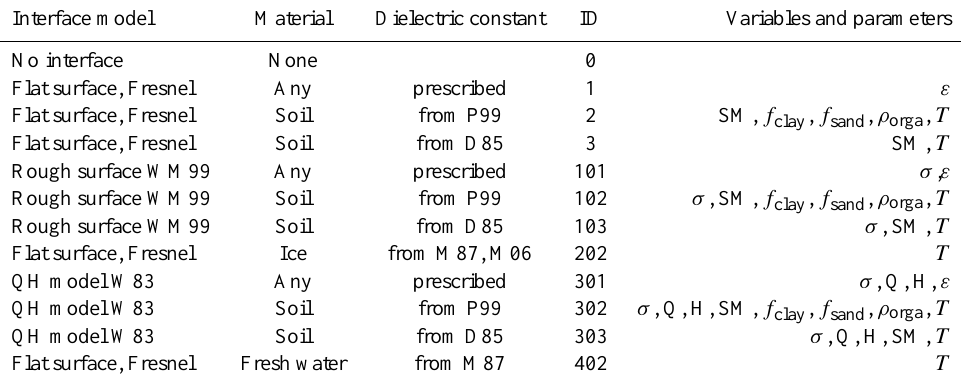
Table 1. Available models for the reflection coefficient of the bottom interface and required input variables and parameters. SM is the soil moisture (volume fraction), ε is the complex dielectric constant, σ is the surface root mean square height (in meters), f clay and f sand are the fractions of clay and sand, ρ orga is the density of dry organic matter (kg m − 3 ), T is the temperature (in K) and Q and H are dimensionless parameters. P99 stands for Pulliainen et al. (1999), D85 for Dobson et al. (1985), M87 for M¨atzler and Wegm¨uller (1987) and M06 for M¨atzler et al.